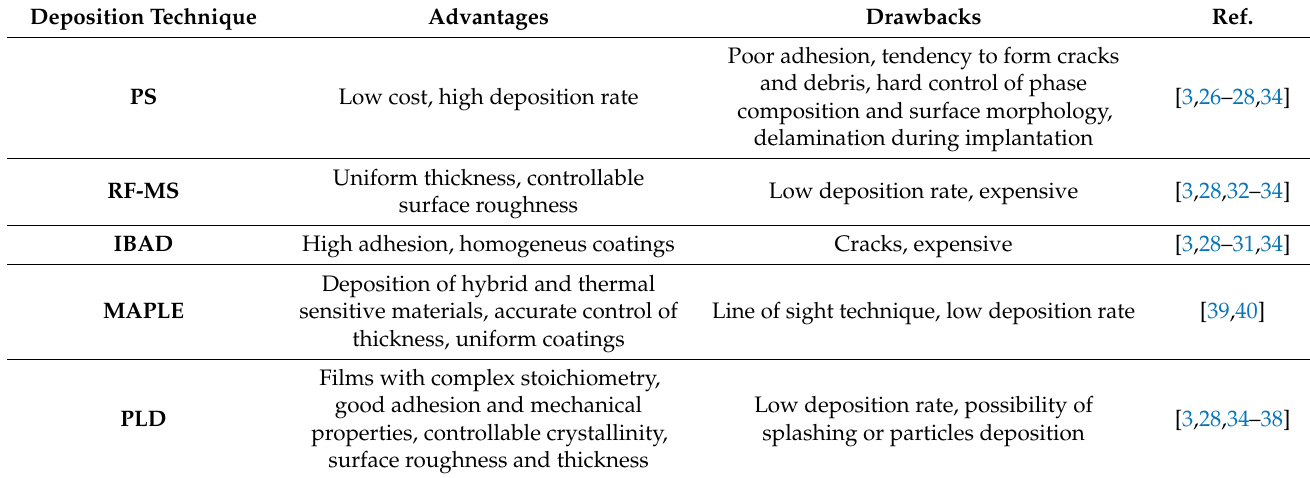
Table 1. The most frequently used plasma-assisted deposition techniques to deposit bioactive ceramic films. Deposition Technique Advantages Drawbacks